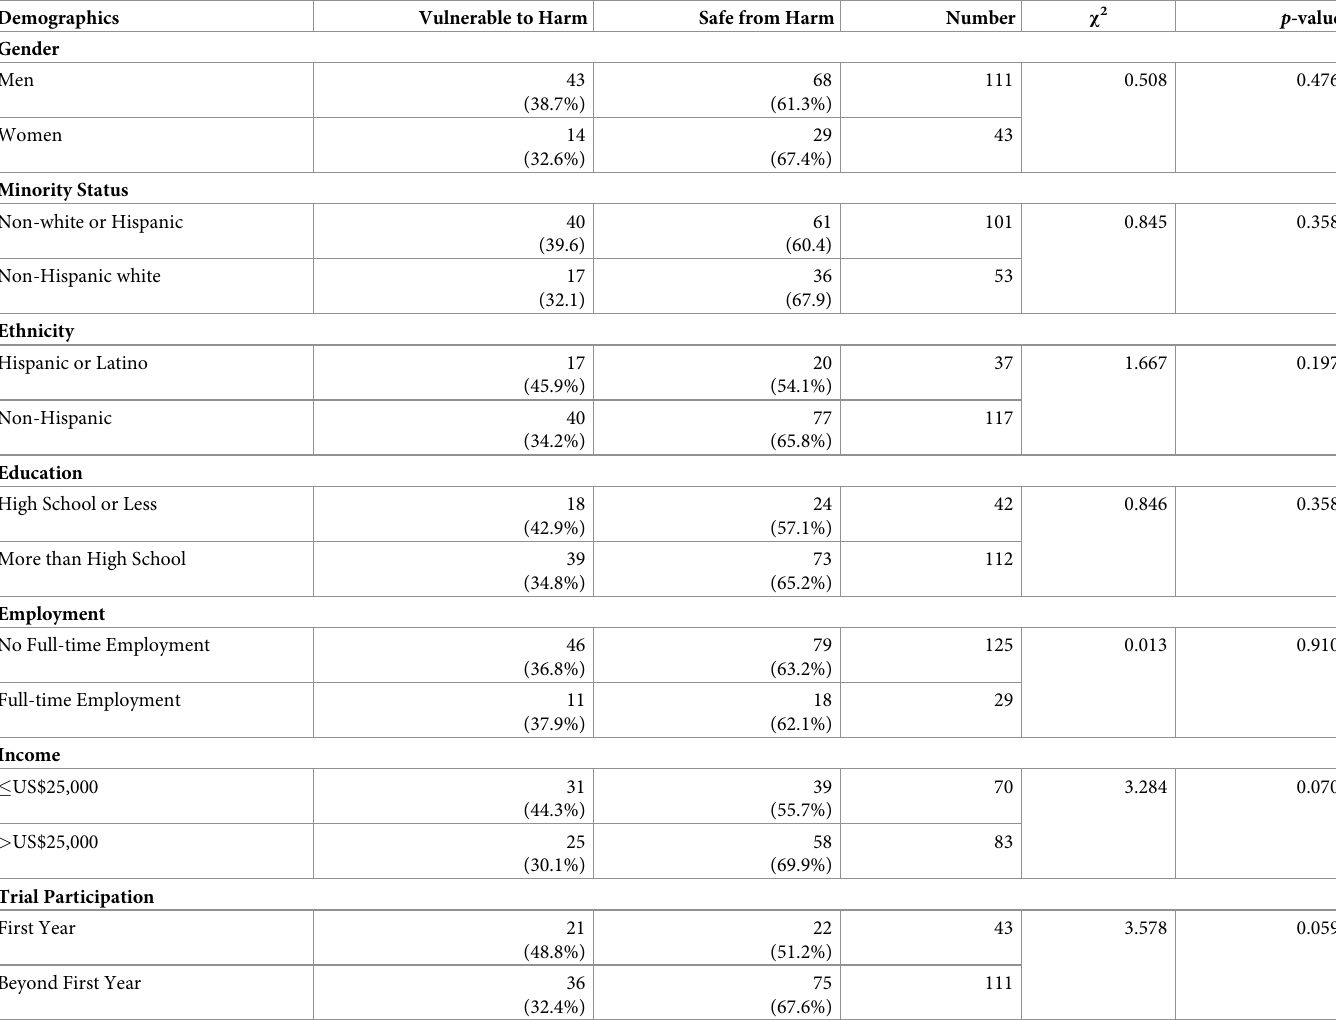
Table 8. Demographic differences in perceptions of personal risk of